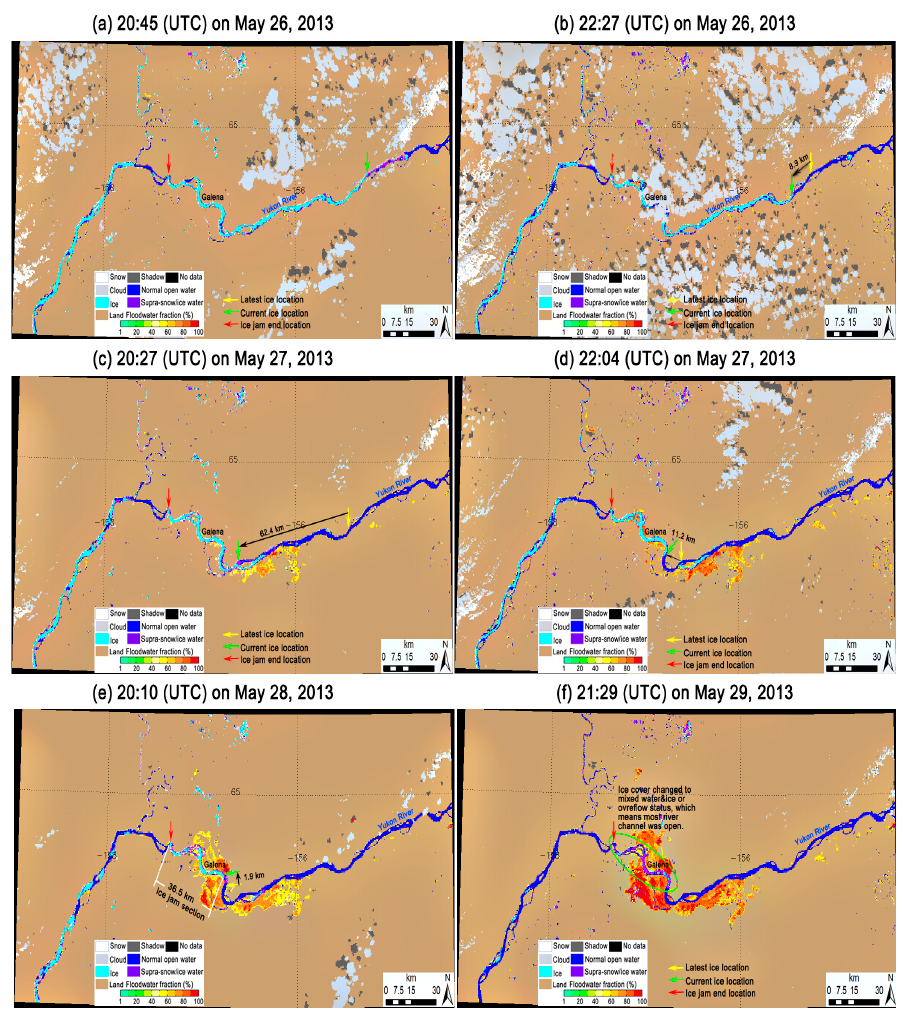
Figure 4. The flood detection maps at 20:45 UTC ( a ) and 22:27 UTC ( b ) on May 26; and at 20:27 UTC ( c ) and 22:04 UTC ( d ) on May 27, 20:10 UTC on May 28 ( e ) and 21:29 UTC on May 29 ( f ), 2013. Yellow arrow displays the latest ice location, green arrow indicates current ice location, and red arrow marks the ice jam